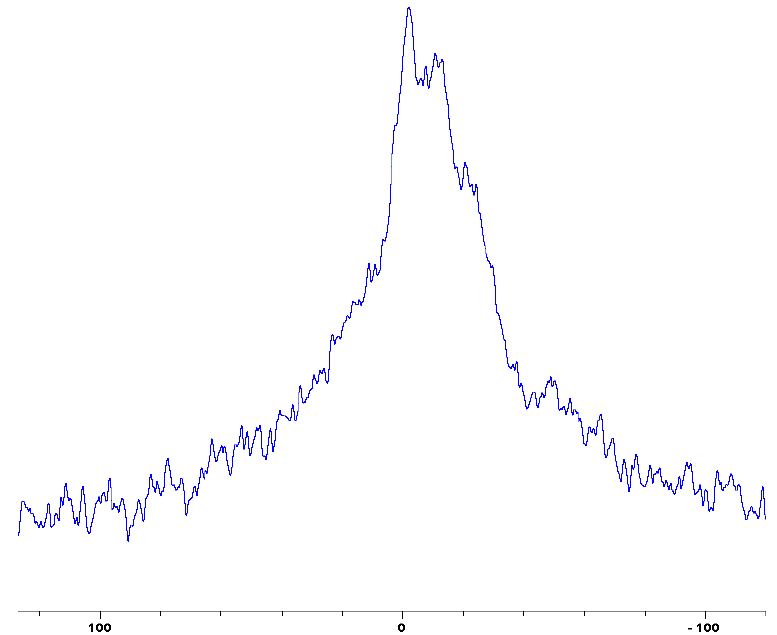
Figure 7. Solid-state 31 P-NMR spectrum of char obtained from fish gelatin + triethylphosphate (TEPa) (the abscissa denotes the chemical shift values, δ , in ppm and the ordinate corresponds to the signal intensity in arbitrary units).